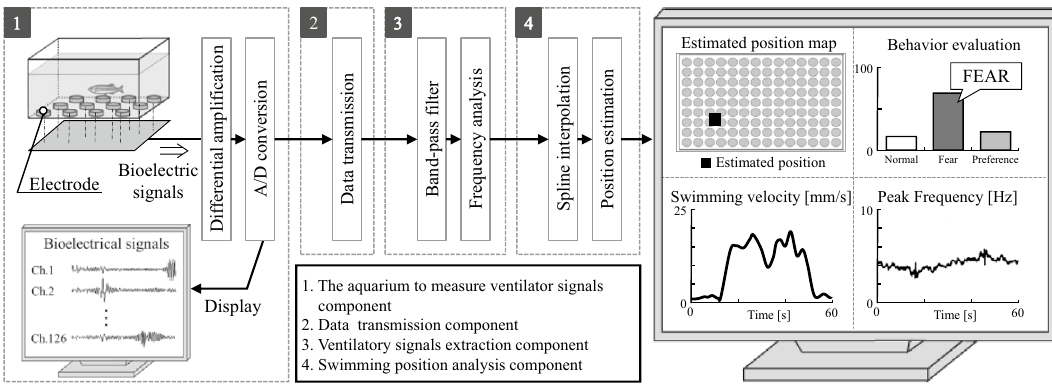
Figure 1. Structure of 2.1 real-time cameraless behavioral analysis system based on ventilatory signals (adapted from Ref. 7 ). The system consists of an aquarium component for measuring ventilatory signals, a data transmission component, a ventilatory signals extraction component, and a component for estimating the position. The estimated position, the velocity, the peak frequency of the ventilatory signals, and an evaluation of the results are displayed on a PC